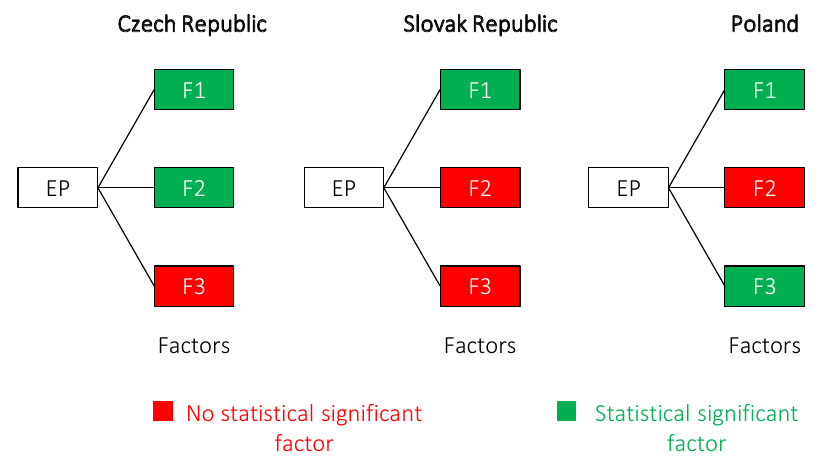
Figure 3. Results of general regression